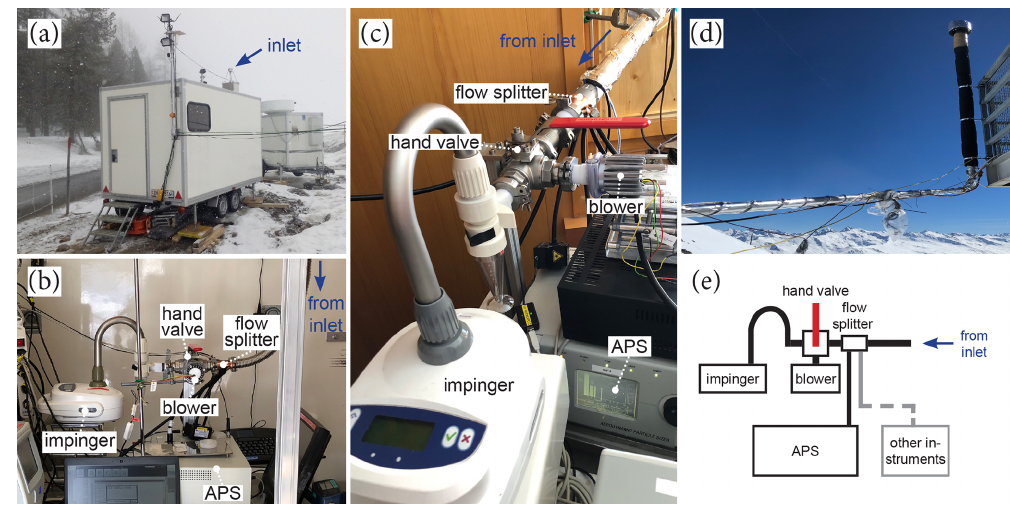
Figure 2. Aerosol measurement setups at WOP and WFJ. The aerosol trailer at WOP (a) , with the heated inlet on the roof (blue arrow), the setup inside the aerosol trailer (b) , the setup at WFJ (c) , with the inlet pipe indicated (blue arrow), and the inlet mounted on a railing at WFJ (d) . The schematic (e) depicts the flow connections used at both sites.